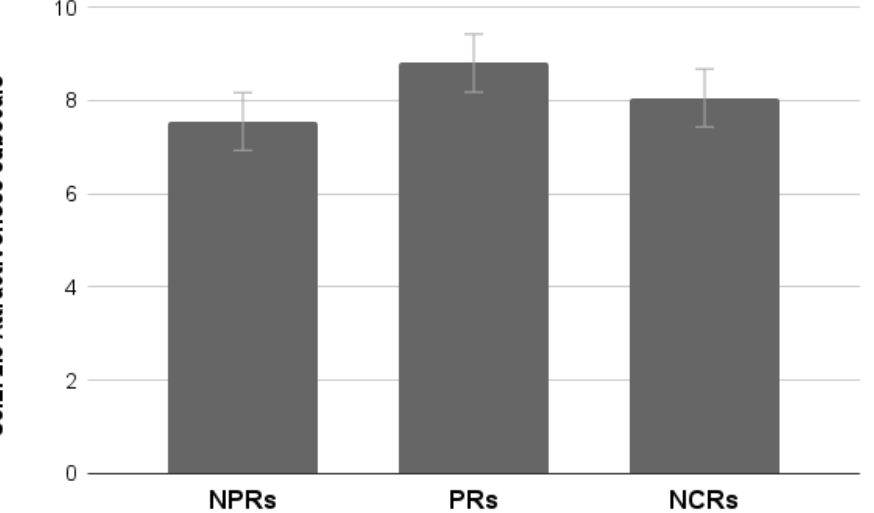
Figure 16. Us.E. 2.0 Attractiveness subscale score by Group (NPRs vs. PRs vs. NCRs). Error bars denote 0.95 confidence intervals.